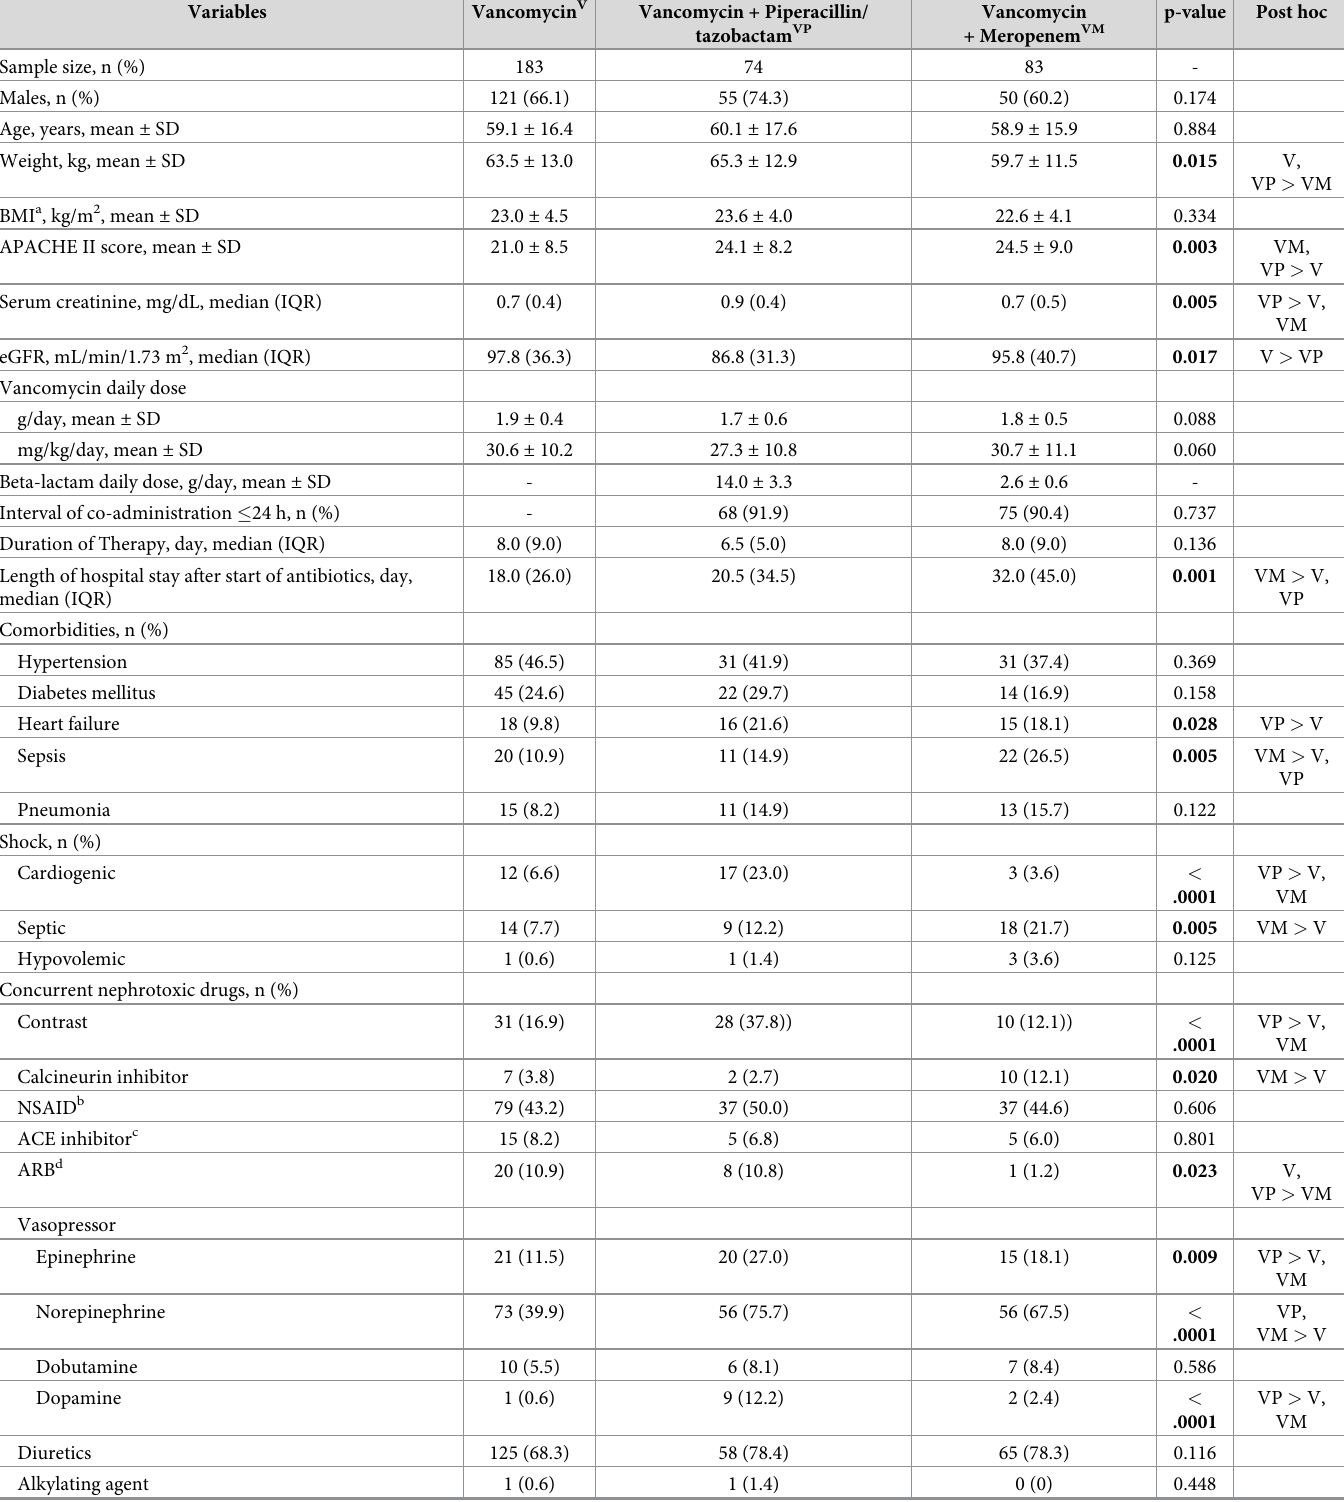
Table 1. Patient characteristics according to antibiotics